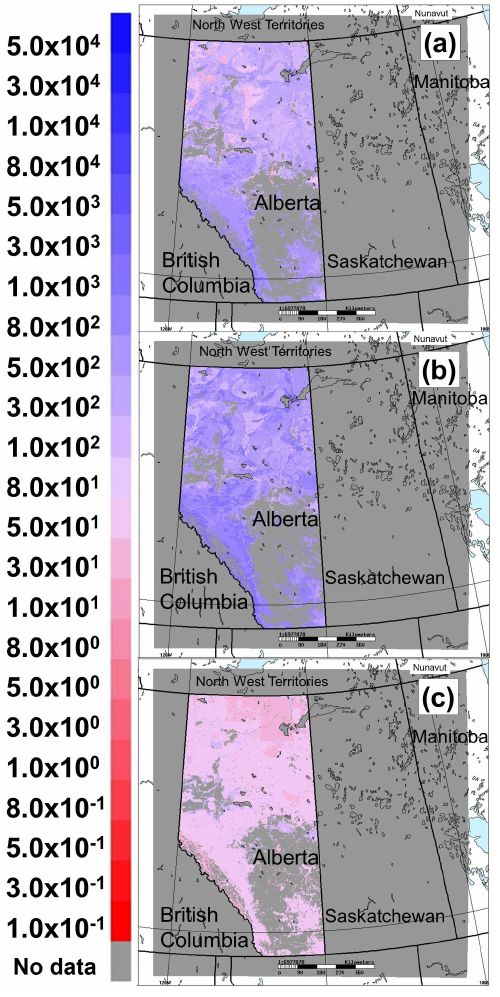
Figure 4. Critical loads of acidity with respect to sulfur and nitro- gen for terrestrial ecosystems, Province of Alberta implementation (eqha − 1 yr − 1 ), using BC dep from interpolated/extrapolated 1994– 1998 observations. (a) Maximum critical load for sulfur. (b) Max- imum critical load for nitrogen. (c) Minimum critical load for ni- trogen. No data: data were only collected within the province of Alberta (outside of Alberta, no data reflect the limitation of data collection); within Alberta, data were only collected for natural ter- restrial ecosystems (no data within Alberta thus refer to landscapes modified by human activities such as